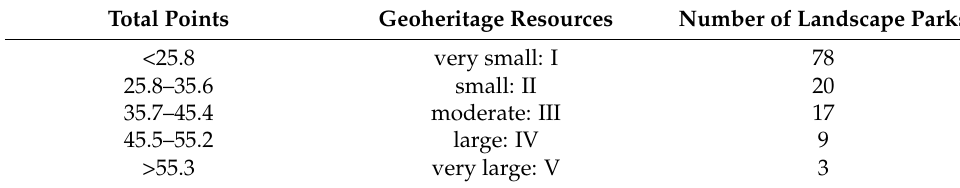
Table 2. The scoring rules and number of landscape parks in the specific